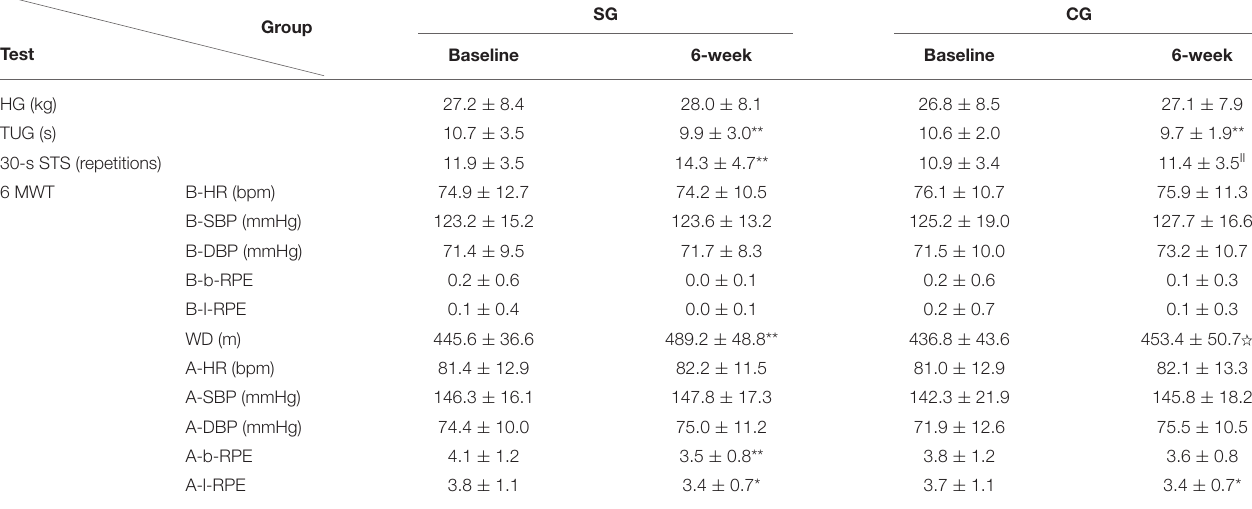
TABLE 3 | Results of motor function test ( x ± s ).